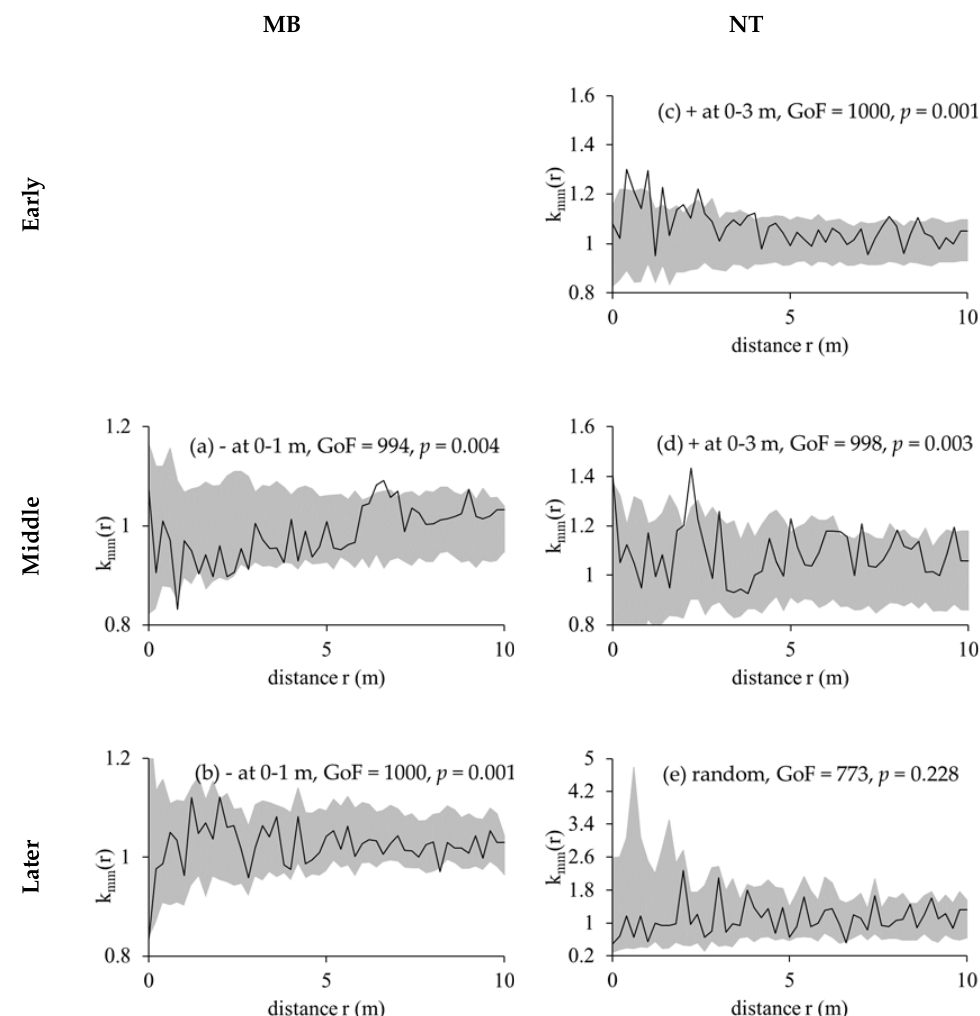
Figure 4. Mark correlation functions of MB (moso bamboo, a , b ) and NT (native forest, c , d , e ) in different bamboo expansionary phases for early, middle, and later plots. Black solid lines denote the observed mark correlation function. The envelopes (grey areas) denote the range of the mark differentiation function of a random assignment of tree size marks and were constructed using 99% quantiles of 999 Monte Carlo simulations based on the independent marking null model. Observed lines that fall above the simulation envelopes indicate that the sizes of neighbouring trees were significantly larger than the population average. Observed lines that fall below the simulation envelopes indicate trees heights of individuals close to each other that were smaller than the population average. If the rank of the test was larger than 950 (990), the data showed a significant or extremely significant departure from the null model with an error rate a = 0.05 (extremely significant departure, a =